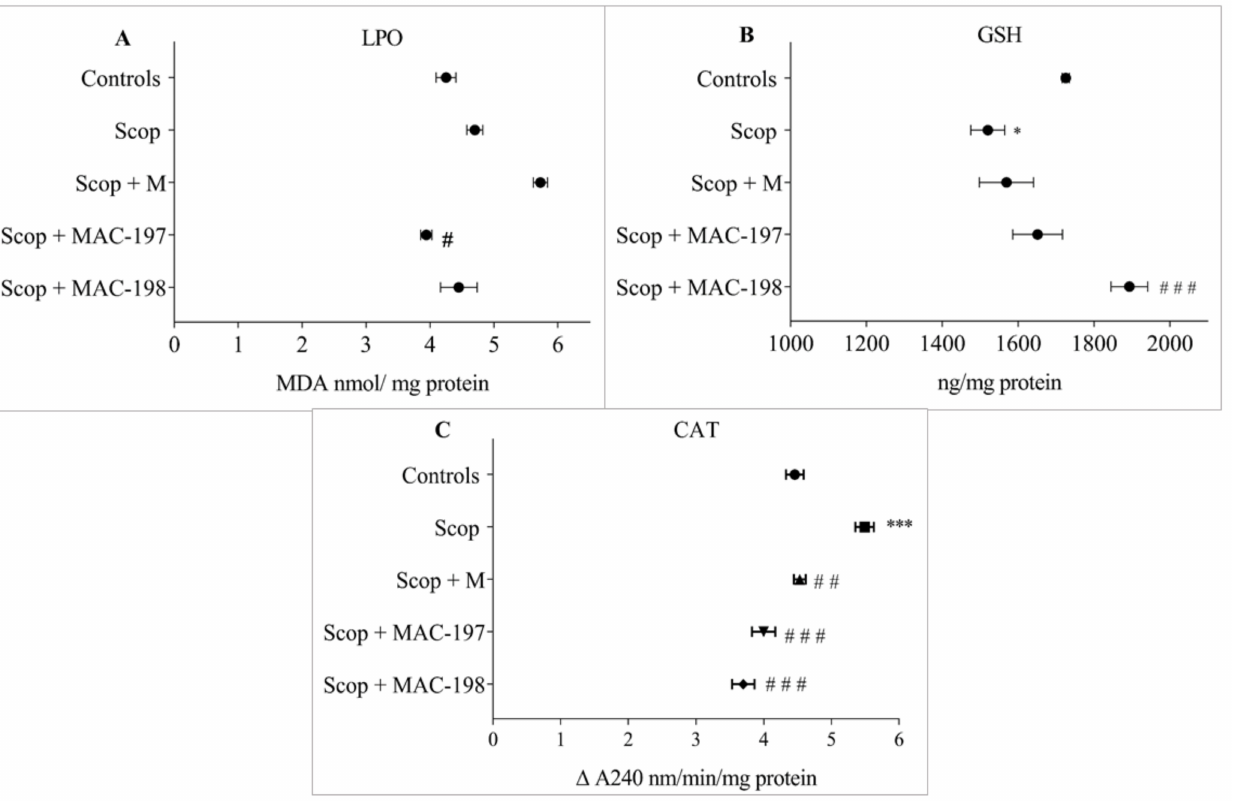
Figure 9. Antioxidant effects of MAC-197 and MAC-198 in brain cortex in rats with scopolamine- induced dementia—lipid peroxidation (LPO) products level ( A ), GSH content ( B ), and CAT activity ( C ); M (40 mg/kg) was used as a referent; data are expressed as the mean ± SEM (n = 5). * p < 0.05, *** p < 0.001 vs. Controls; # p < 0.05, # # p < 0.01, # # # p < 0.001 vs. Scop